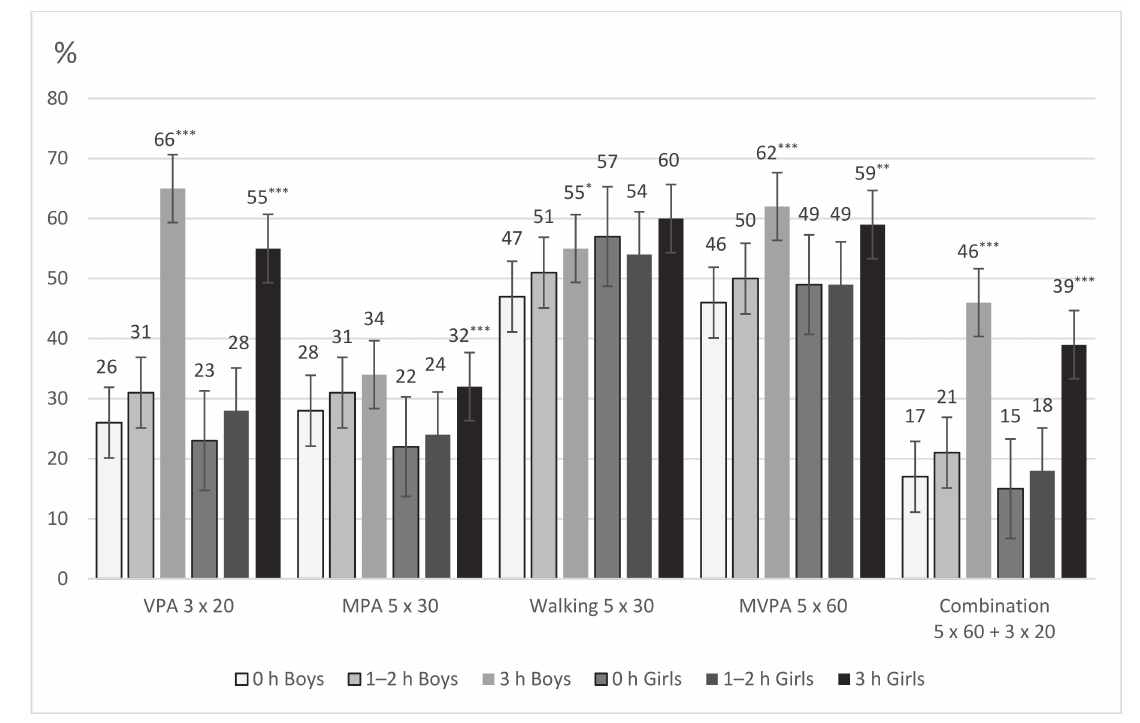
Figure 2. Achievement of the recommendations for weekly physical activity (3 × 20 min of vigorous PA (VPA), 5 × 30 min of moderate PA (MPA), 5 × 30 min of walking, 5 × 60 min of moderate to vigorous PA (MVPA), and 5 × 60 min of MVPA combined with 3 × 20 min of VPA) by boys’ and girls’ participation in organized physical activity. Significant difference between groups (0 lessons and ≥ 3 lessons of OPA): * p < 0.05; ** p < 0.01; *** p <